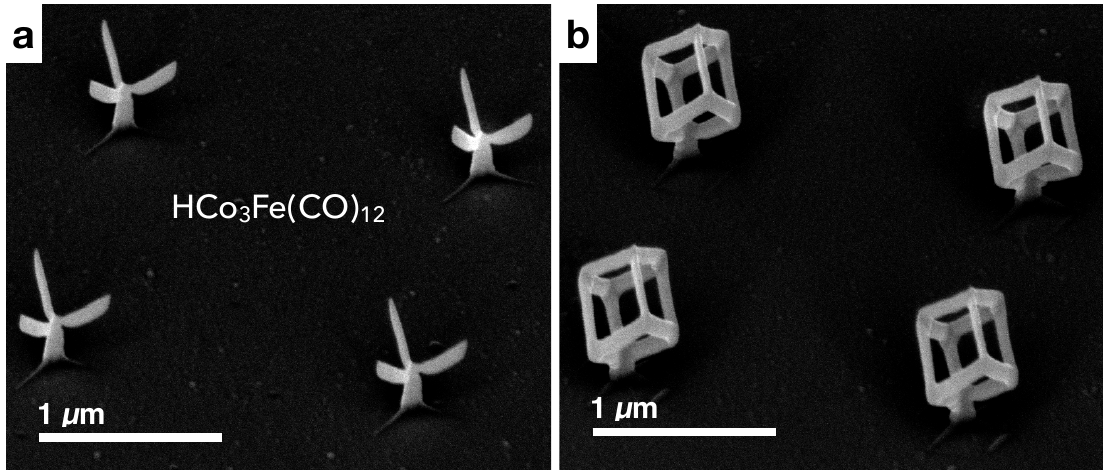
Figure 1. ( a ) SEM image of 2 2 array of non-coupled nano-trees. Note the varying cross section of the × branches emanating from the vertical stem; ( b ) SEM image of 2 2 array of non-coupled ×